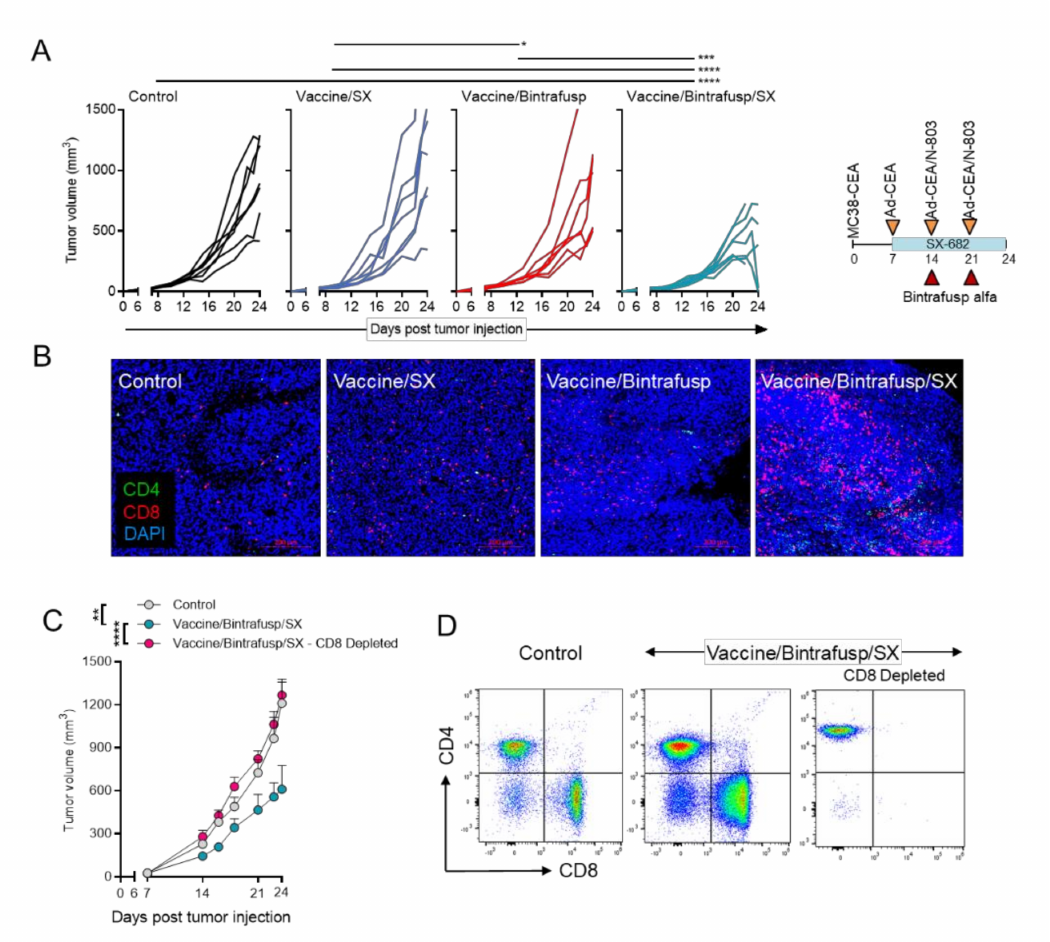
Figure 2. Vaccine combination immunotherapy is dependent on CD8 + TIL. ( A ) CEA.Tg mice were injected s.c. with 3 × 10 5 MC38-CEA in the flank. On day 7, mice were started on a control or SX-682 diet (200 mg/kg body weight/day). On days 14 and 21, mice received i.p. injections of 200 µ g bintrafusp alfa. A priming vaccine dose of s.c. Ad-CEA (1 × 10 10 viral particles) was administered on day 7 with a boosting dose of Ad-CEA/N-803 vaccine on days 14 and 21 (1 × 10 10 viral particles, N-803, 1 µ g, s.c.). Shown are the individual tumor growths for mice in the Control, Vaccine/SX, Vaccine/Bintrafusp, and Vaccine/Bintrafusp/SX groups; n = 7 mice/group. Control indicates mice that were left untreated and fed a base diet without SX-682. ( B ) Representative images of indicated tumors stained for CD4 + (green) and CD8 + (red) T cells and DAPI (blue) by immunofluorescence. ( C ) MC38-CEA tumor-bearing CEA.Tg mice received Vaccine/Bintrafusp/SX as in ( A ). Additionally, mice receiving Vaccine/Bintrafusp/SX also received depleting antibodies for CD8 + cells starting on day 5; n = 7 (Control and Vaccine/Bintrafusp/SX – CD8 Depleted) or 5 (Vaccine/Bintrafusp/SX) mice/group. ( D ) Flow profiles confirming efficacy of CD8 depletion antibodies from ( C ). Error bars indicate SEM of biological replicates. * p ≤ 0.05; ** p ≤ 0.01; *** p ≤ 0.001; **** p ≤ 0.0001 for two-way ANOVA in ( A , C ). i.p. = intraperitoneal. s.c. = subcutaneous. TIL = tumor- infiltrating